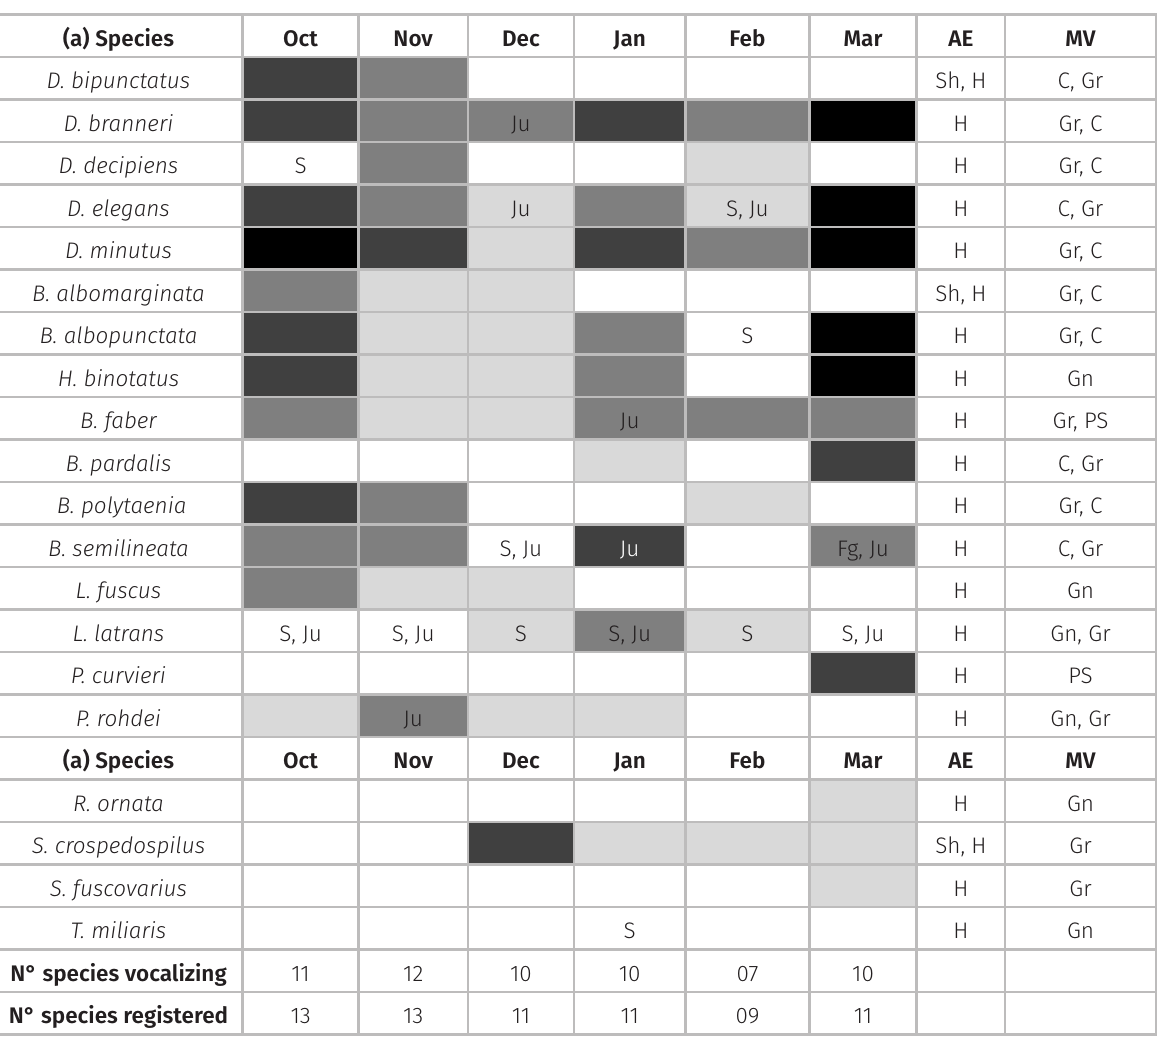
Table III. Areas in the Municipality of Barão de Monte Alto, State of Minas Gerais, Brazil. Male classes in vocalization activity: - 1-2; - 3-10; - 11-50 and - over 50. S: Found only individuals that were not vocalizing; Ov: ovate; Ju: juvenile; Fg: froglet. AE (Arboreal Extract): H: herbaceous; Sh: shrubby. MV (Microenvionment Vocalization): Lt: litter; Gn: ground; Gr: grass; C: cattail; Ro: rock; Rt: root, PS: partially submerged. Months of the rainy season (2013 – 14 and 2014 –